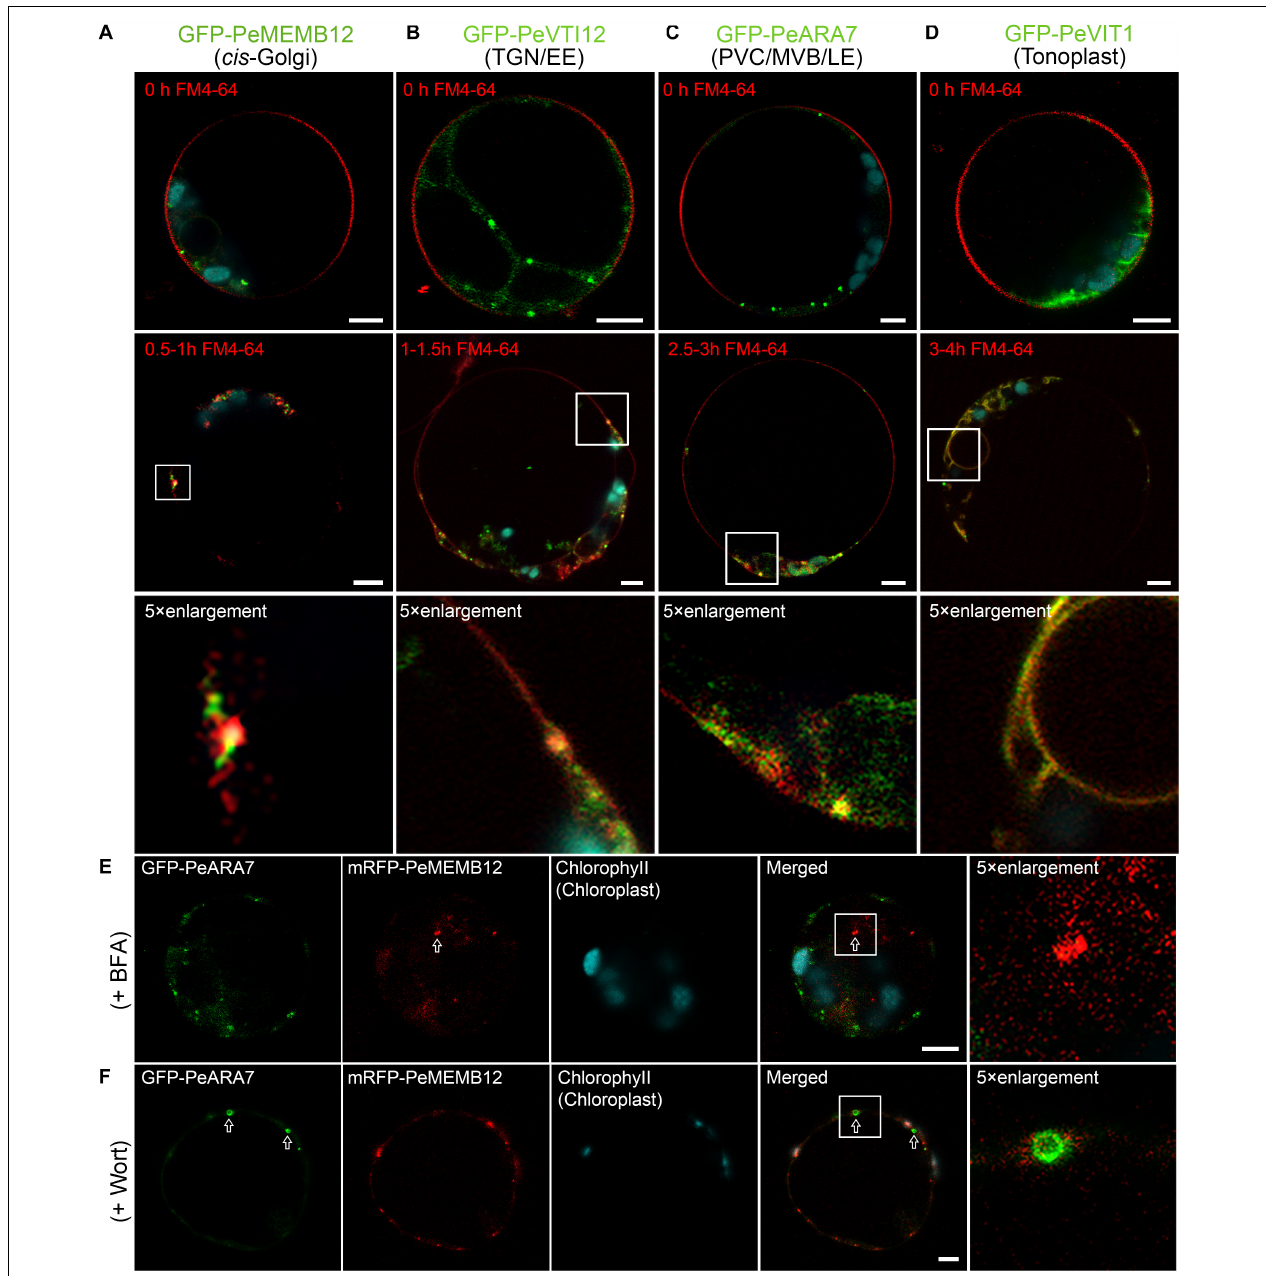
FIGURE 6 | Functional mapping of endosomal compartment markers by combinatorial colocalization. (A–D) Time course of FM4-64 uptake in moso bamboo protoplasts expressing different endosomal markers. Colocalization analysis of GFP-labeled compartments (green) with the endocytic tracer FM4-64 (red) after 0.5–1 h ( A , middle panel), 1–1.5 h ( B , middle panel), 2.5–3 h ( C , middle panel), or 3–4 h (D, middle panel) of uptake. Some compartments can be clearly defined as colocalizing or non-colocalizing, whereas many show partial colocalization (low panel). Note the time-dependent colocalization of early endosome (EE) TGN or late endosome (LE) prevacuolar compartment/multivesicular body (PVC/MVB) marker with FM4-64. (E) Subcellular localization analysis of PVC/MVB localized GFP–PeARA7 with cis -Golgi localized mRFP–MEMB12 after brefeldin A (BFA) treatment. The arrow indicates the mRFP–MEMB12 forms large aggregation, while GFP–PeARA7 does not form aggregates. (F) Subcellular localization analysis of GFP–PeARA7 with mRFP–MEMB12 after wortmannin (Wort) treatment. Arrows indicate that GFP–PeARA7 forms ring-like structures, while mRFP–MEMB12 shows no response. Scale bar = 5 µ m.